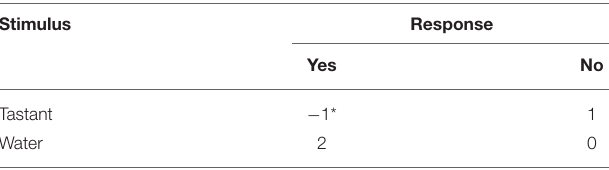
TABLE 2 | Single-interval adjustment matrix: the number of steps to move up or down on the concentration scale based on the previous response.